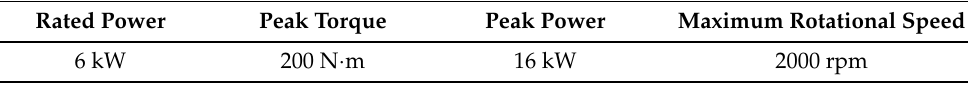
Table 4. ISG motor parameters of four-wheel drive HEV. Table 5. In-wheel motor parameters of four-wheel drive HEV. Table 5. In-wheel motor parameters of four-wheel drive HEV.